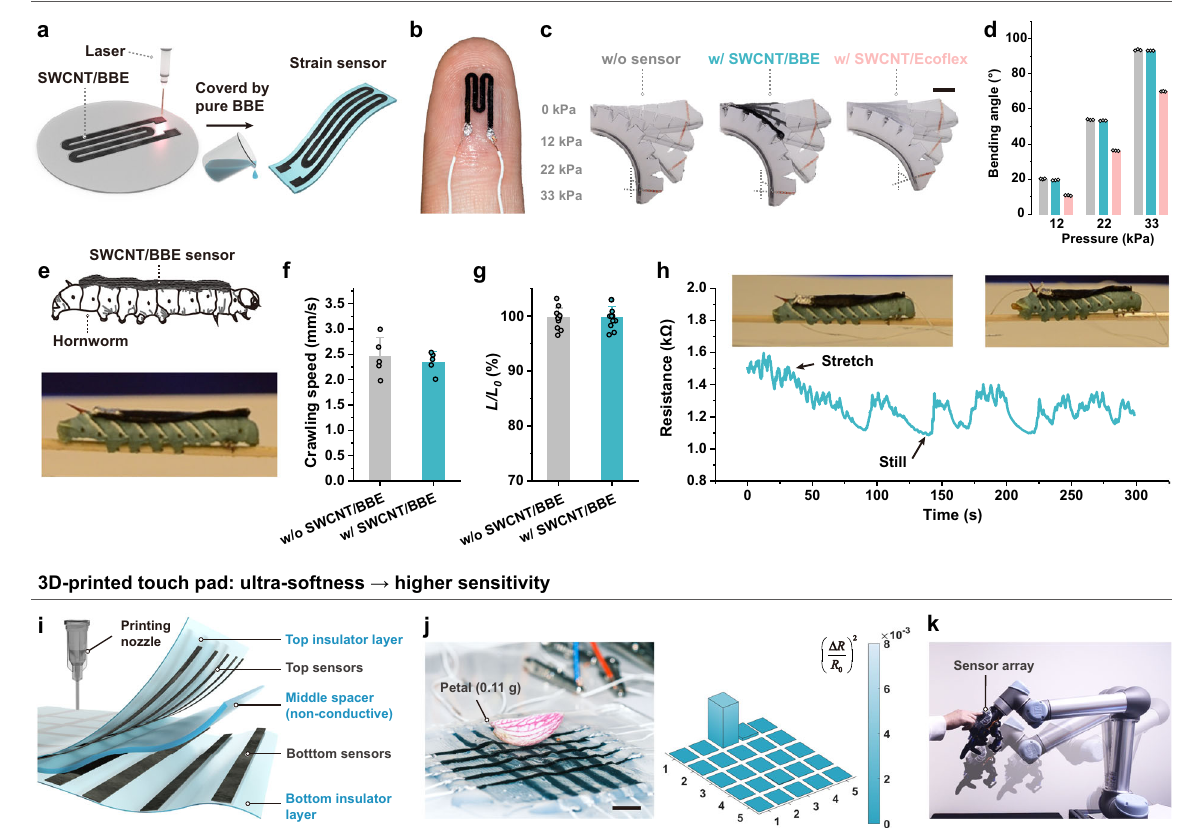
Fig. 4 | Laser-cut strain sensors and 3D-printed touch pad based on ultrasoft BBEs. a The schematic of the fabrication process of laser-cut strain sensors. b Photograph of the laser-cut strain sensor adhered on the fi ngertip of a human hand. The strain sensor can easily attach on human body due to its self-adhesive property. c Overlaid photographs of a pneumatic actuator (in fl ated at different pressure levels) without sensor, with a SWCNT/BBE strain sensor, and with a SWCNT/Eco fl ex strain sensor. The in fl ation pressure levels were kept the same for thethreegroups.Thescalebaris1cm. d Bendinganglesofthepneumaticactuators under12kPa,22kPa,and33kPaofin fl atedpressurein c :withoutsensor(gray),with a SWCNT/BBE strain sensor (blue), and with a SWCNT/Eco fl ex strain sensor (pink).